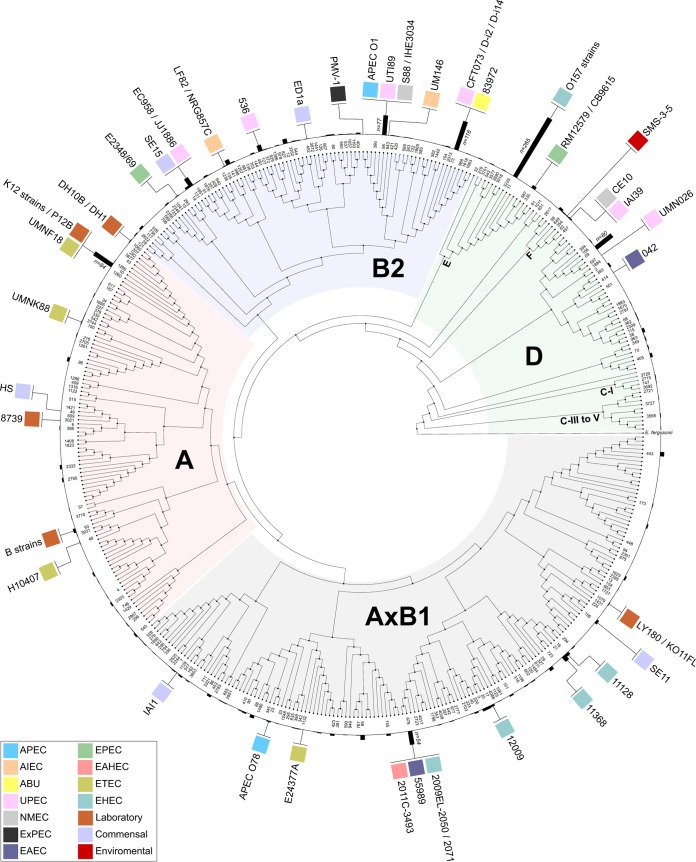
Phylogeny of E. coli strains in EcoDS. Phylogenetic tree demonstrating the relationship of MLSTs in EcoDS. Major phylogroups A, B1, B2, and D, as well as minor phylogroups E, F, C-I, and C-III to -V, are indicated. Completely sequenced strains are indicated according to their pathotype association (see the inset for the color-coded legend): (i) O157 strains, EDL933, Sakai, TW14359, EC4115, and Xuzhou21; (ii) K-12 strains, MC4100, MDS42, W3110, MG1655, c321.deltaA, and BW2952; and (iii) B strains, REL606, BL21(DE3), and BL21-Gold(DE3)(pLysS) AG. Histograms represent the number of genomes in the respective ST within EcoDS. STs represented by more than 50 genomes are indicated. Open circles represent STs that belong to a different phylogroup.